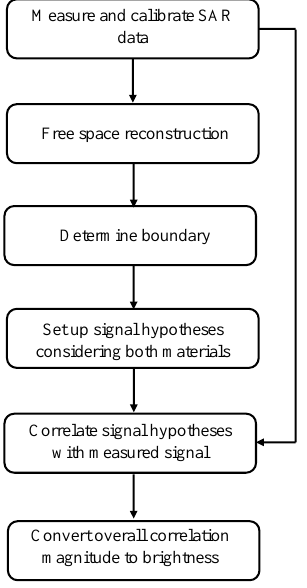
Figure 2. Flowchart of the image reconstruction